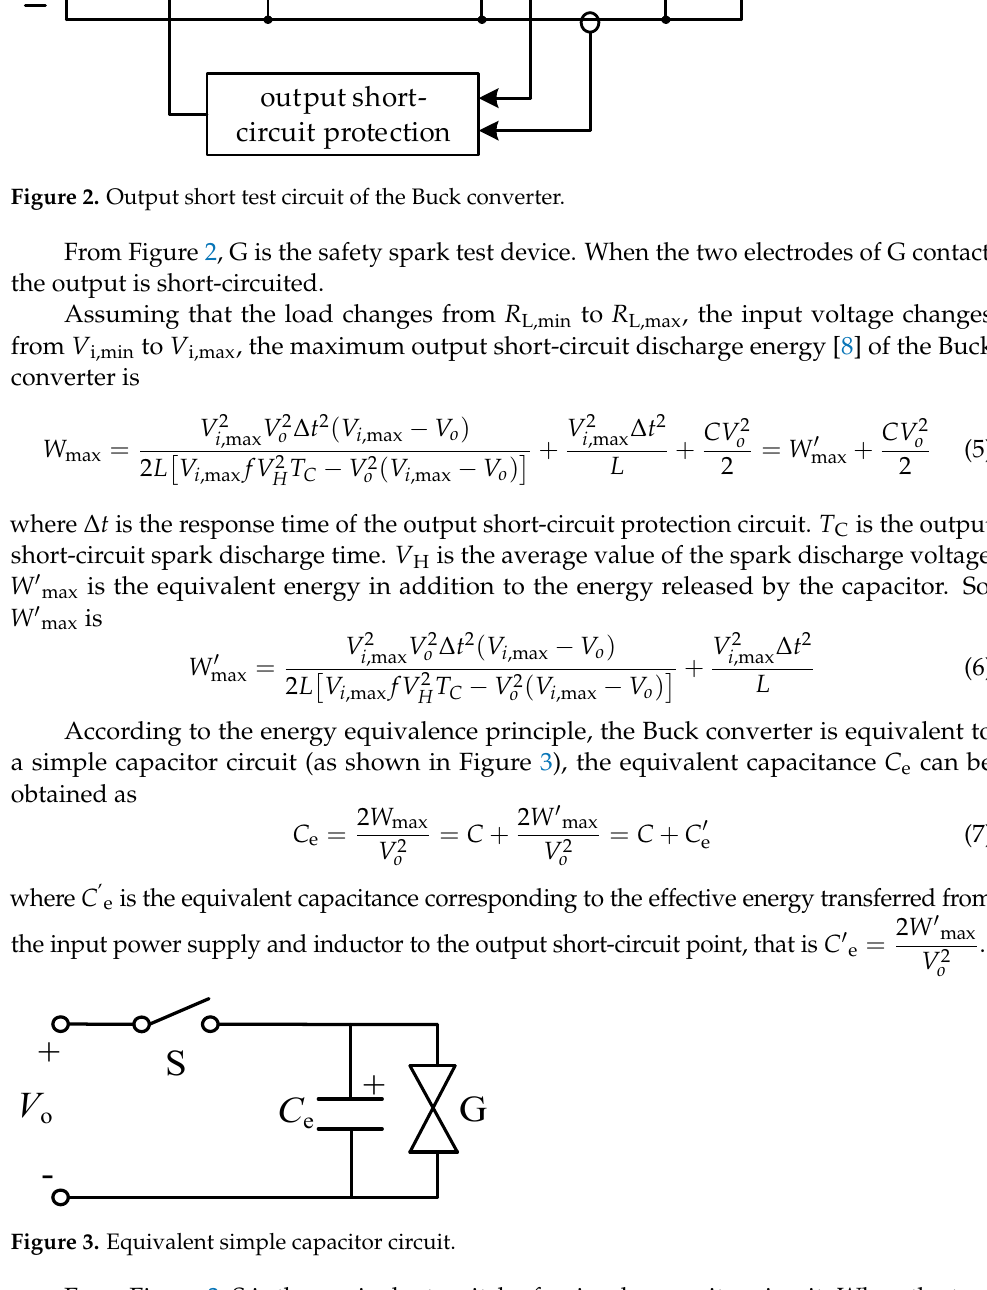
G Figure 3. Equivalent simple capacitor circuit.